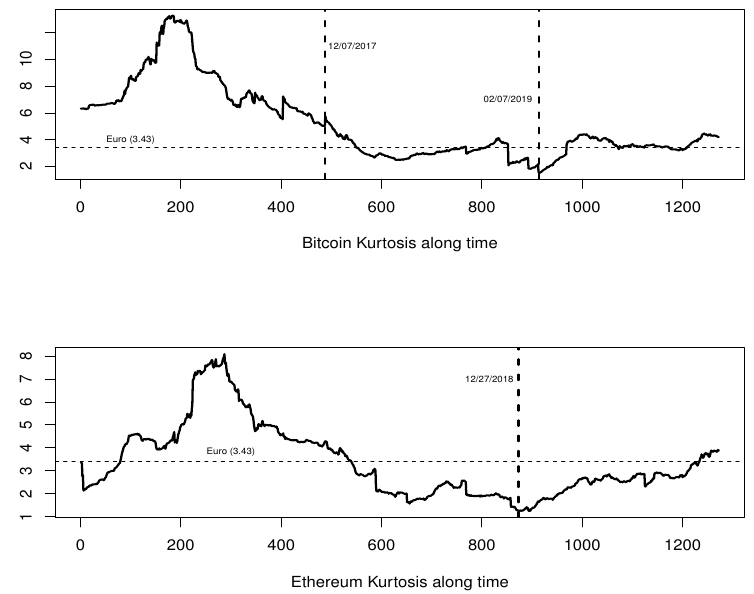
Figure 2. Bitcoin and Ethereum kurtosis dynamic estimates over